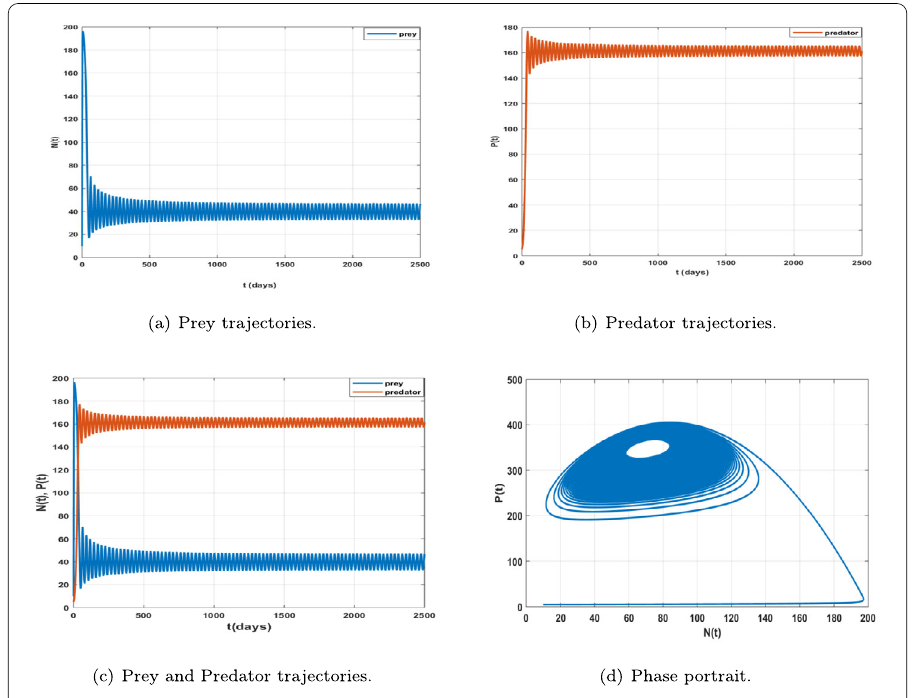
Figure 4 Local asymptotic stability of the coexisting equilibrium of system (2.3) corresponding to δ 1 = 0.033